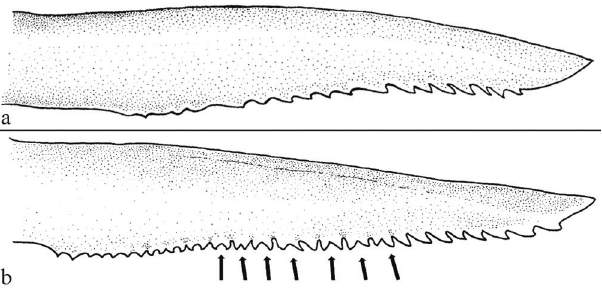
Fig. 2. Pectoral-fin spine of Corydoras lacrimostigmata (a), NUP 14657, paratype, 30.9 mm SL, showing the serrations in posterior margin of the right spine (6.0 mm) and Corydoras flaveolus (b), LBP 14596, 33.5 mm SL, showing the serrations in posterior margin of the right spine (8.0 mm). Arrows indicate bifid